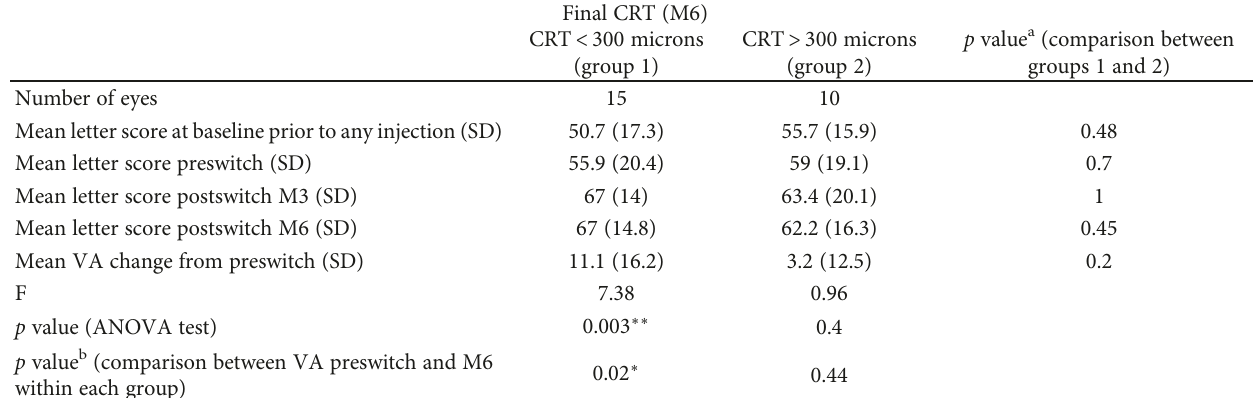
Table 4: Subgroup analysis according to CRT < 300 or ≥ 300 μ m at